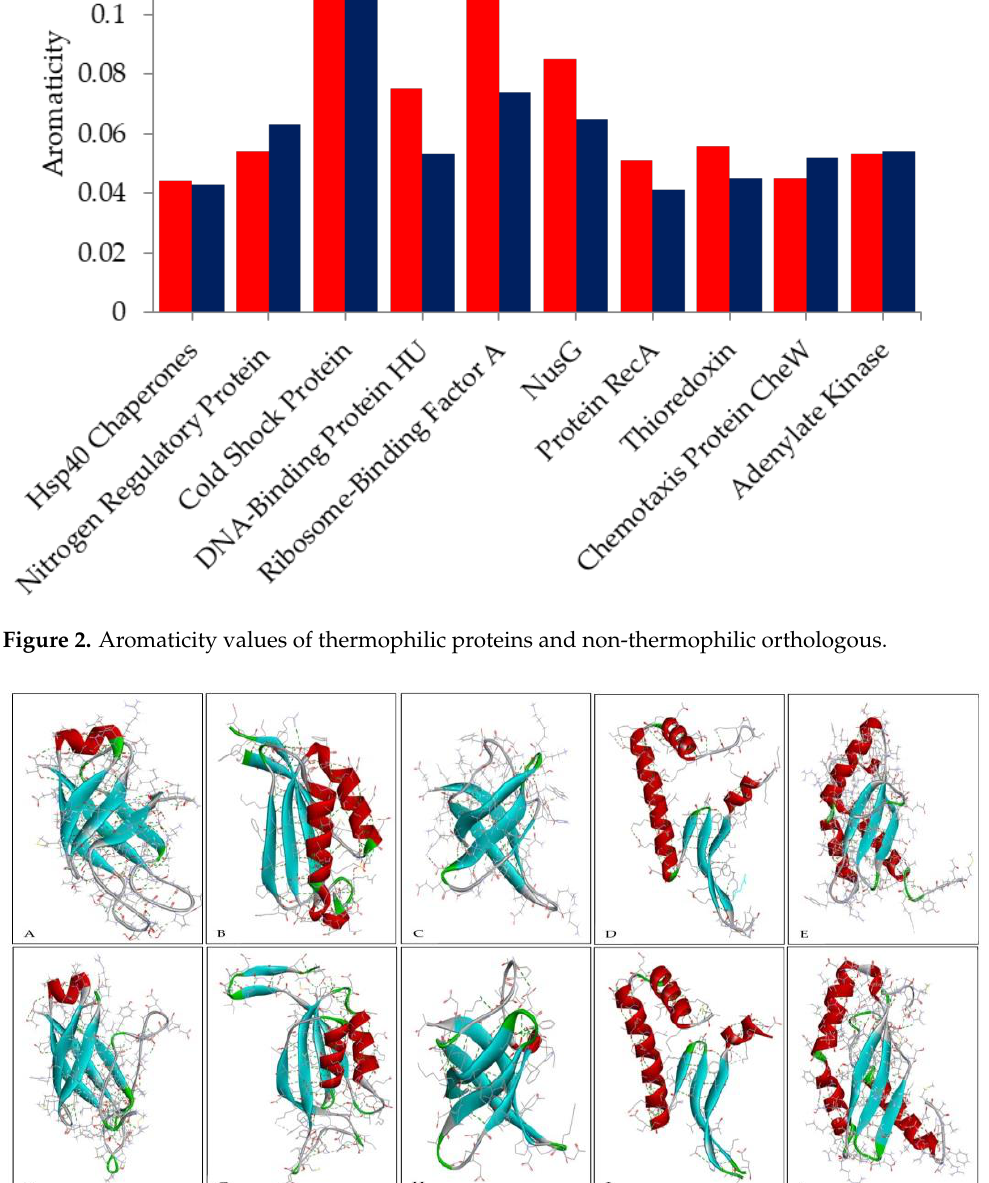
Figure 4. ( A – E ) show the structure of thermophilic protein transcription antitermination protein NusG, protein RecA, thioredoxin, chemotaxis protein CheW, and adenylate kinase, respectively. ( F – J ) shows the structure of their non-thermophilic orthologs, respectively. Coil structure is shown in gray, helix in red, sheet in blue, and turn in green. Conventional hydrogen bonds are repre- sented by the dotted green line, carbon-hydrogen bonds by the light green dotted line, and salt bridges by the dotted yellow line. A helix is a structure formed by hydrogen bonding between every fourth amino acid in a way that makes the side chain of residues directed outward and away from the hel- ical axis, thus allowing the charged residues of the helix to form stable interactions with other elements and resulting in greater stability in the protein structure [63]. The sec- ondary structure analysis showed that most thermophilic proteins, including Hsp40 chaperones, nitrogen regulatory protein, ribosome-binding factor A, transcription anti- termination protein NusG, thioredoxin, and adenylate kinase, have a higher helix per- centage as compared with their non-thermophilic orthologous (Figure 5A).